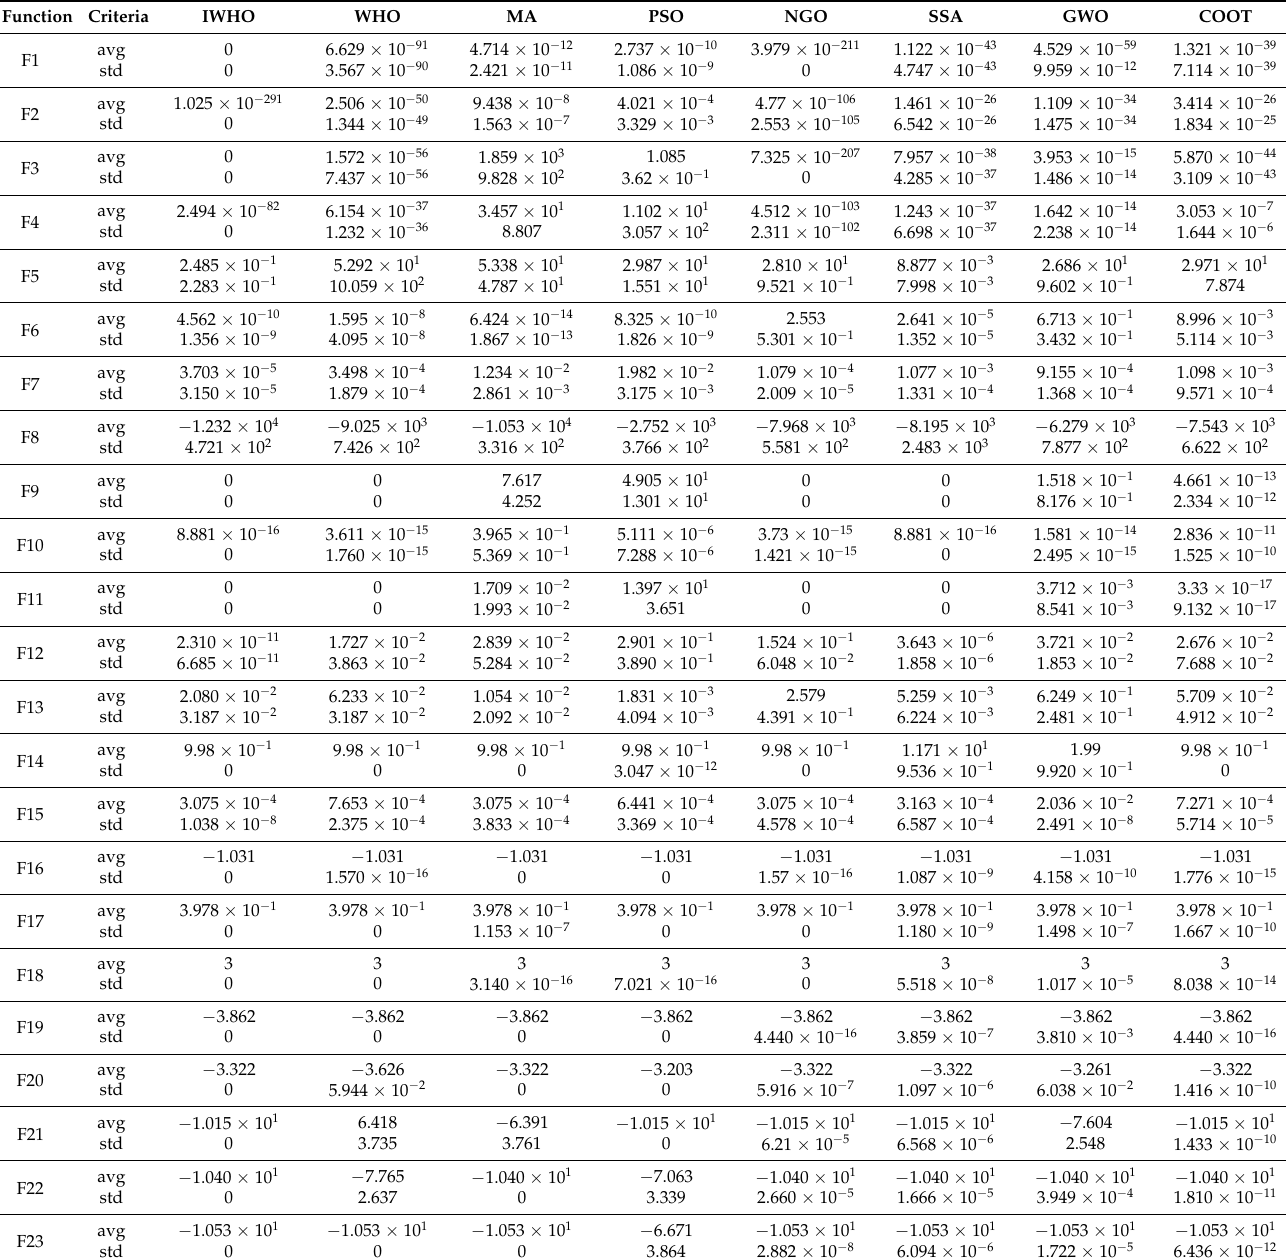
Table 5. Results of single-peak and multi-peak benchmark